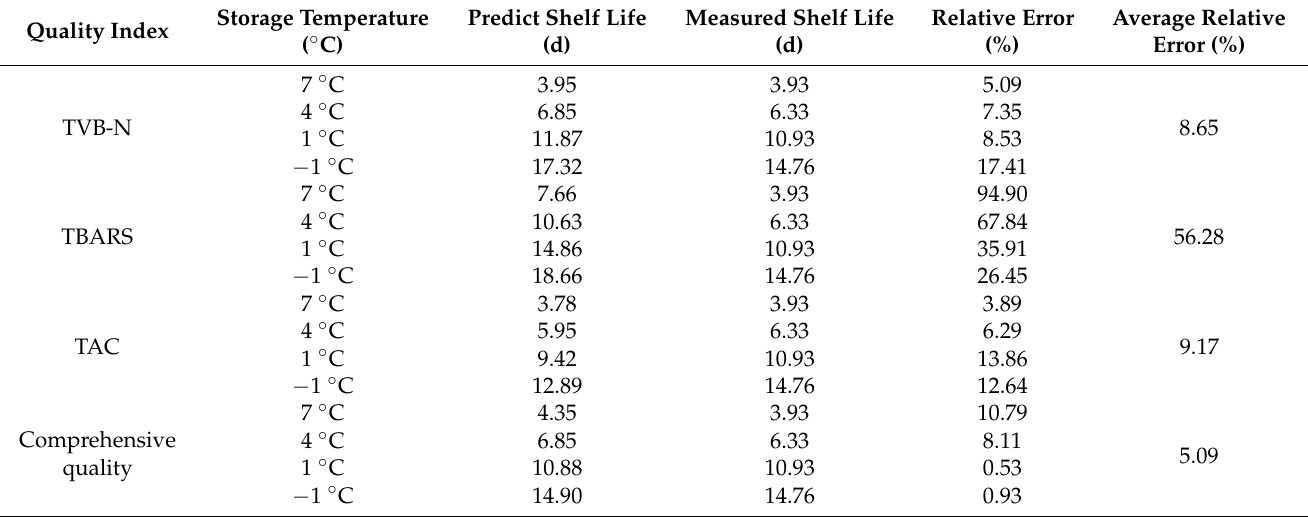
Table 4. Experimental and predicted quality values under different